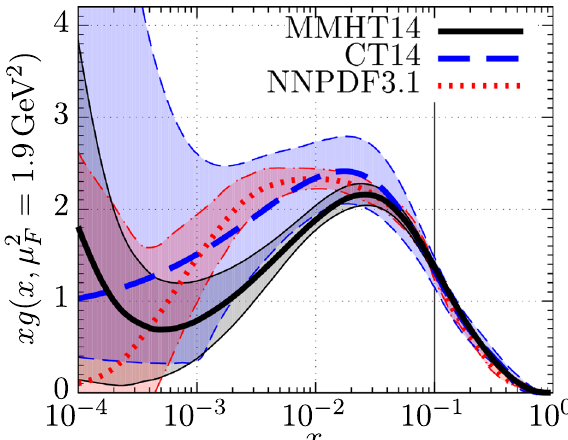
Fig. 1 Low Q 2 = 1 . 9GeV 2 gluondistributionsobtainedviatheglobal parton analyses of MMHT14 [4], CT14 [5], and NNPDF3.1 [6] using LHAPDF [7]